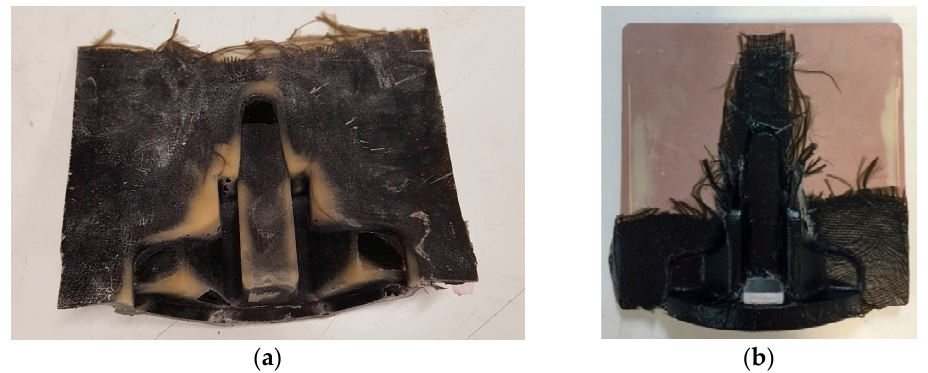
Figure 12. BFRP after the vacuum bag: ( a ) component A and ( b ) component B.